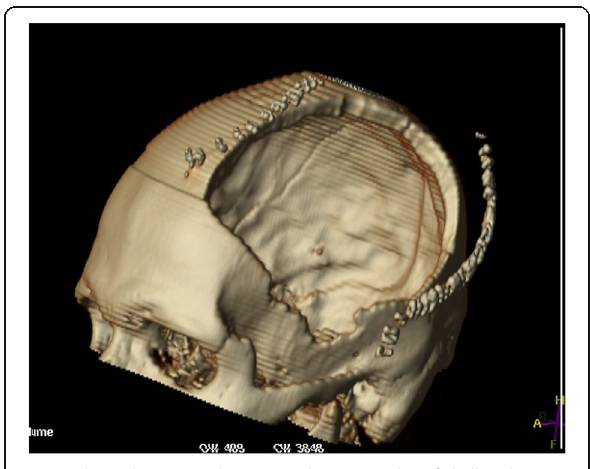
Fig. 1 Three-dimensional computed tomography of skull with decompressive